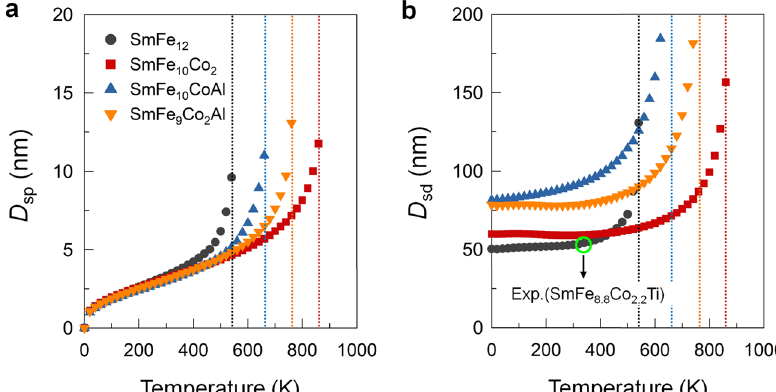
Fig. 8 Temperature-dependent magnetic grain size. a Minimal stable grain size D sp and b single-domain threshold size D sd versus temperature of SmFe 12 , SmFe 10 Co 2 , SmFe 10 CoAl, and SmFe 9 Co 2 Al. Vertical dotted lines denote the Curie temperatures T c . Open circle in b indicates an experimental single-domain size (51 nm) of SmFe 8.8 Co 2.2 Ti at room temperature, taken from ref. 29